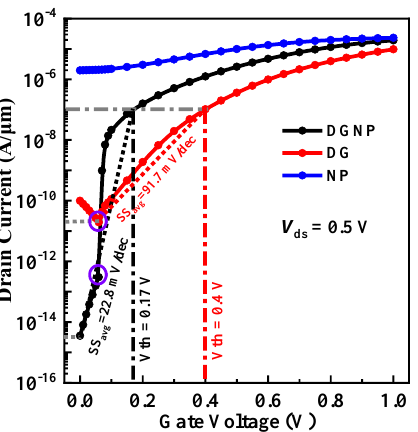
6 of 16 Figure 3. Contour plots of the vertical non-local e-BTBT tunneling rate for ( a ) NP-EHBTFET; ( b ) DG- EHBTFET; and ( c ) DGNP-EHBTFET, in the ON-state. Contour plots of the lateral non-local e-BTBT tunneling rate for ( d ) NP-EHBTFET; ( e ) DG-EHBTFET; and ( f ) DGNP-EHBTFET, in the ON-state. ends downward, so as to provide conditions for vertical tunneling. As shown in Figure 2b, the CG in DG-EHBTFET can induce holes in its right-side region, which forms a PN junction between this region and the drain region, and eventually results in vertical tun- neling in black dotted circles ➂ and ➃ . Figure 2c shows that the vertical tunneling of DGNP-EHBTFET mainly occurs in black dotted circles ➄ and ➅ , and its non-local e-